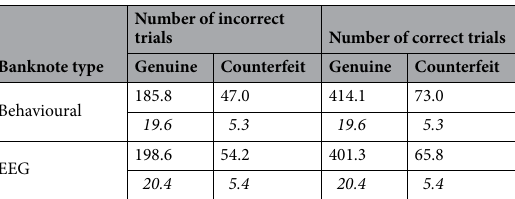
Table 1. Number of correct and incorrect trials for each banknote authenticity type used in the behavioural and EEG analyses. S.e in italics.